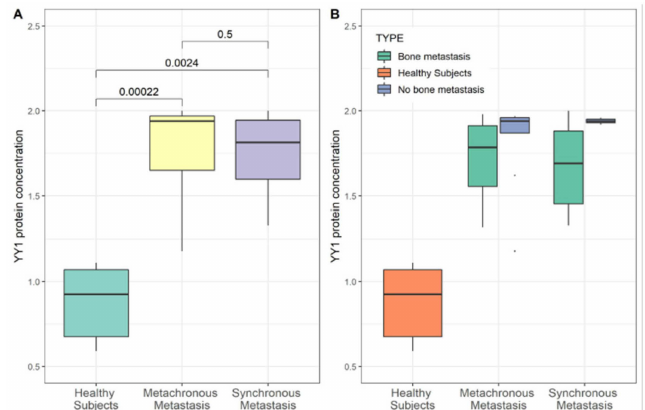
Figure 4. YY1 protein level and metastatic breast cancer. Serum protein level of YY1 in BC patients grouped as “Healthy Subjects” (HS), “Metachronous Metastasis” (MM) and “Synchronous Metastasis” (SM) group. ( A ) Comparison of YY1 protein level between BC patients ( n = 11 SM and n = 26 MM) and HS patients ( n = 15). Protein concentration is reported as ng / mL. Enzyme-linked immunosorbent assay (ELISA) YY1 protein level in BC patient sera indicated a media concentration of 1.8 ± 0.3 ng / ml in MM and 1.7 ± 0.3 ng / ml in SM patients compared to 0.8 ± 0.3 ng / ml in HS ( p < 0.01; p <